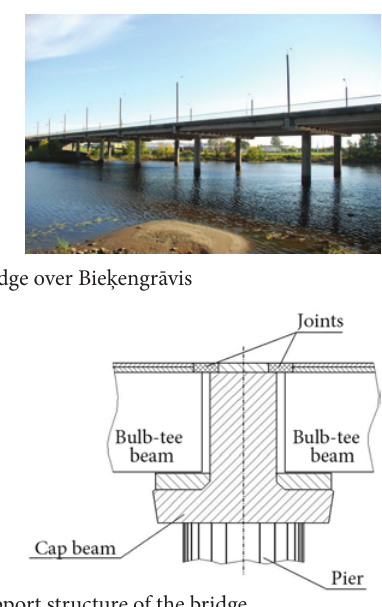
fig. 3. The right-side approach ramps complex of the Salu Bridge over the Daugava River